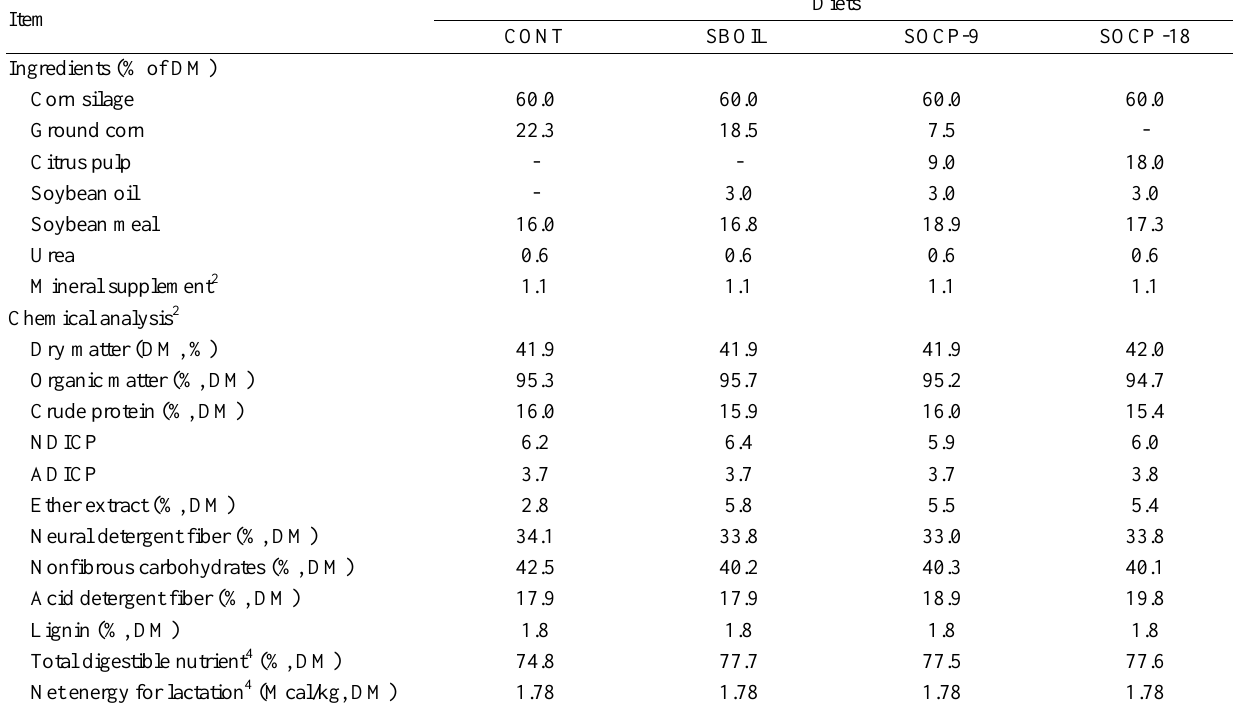
Table 2. Ingredient and chemical composition of total mixed diets